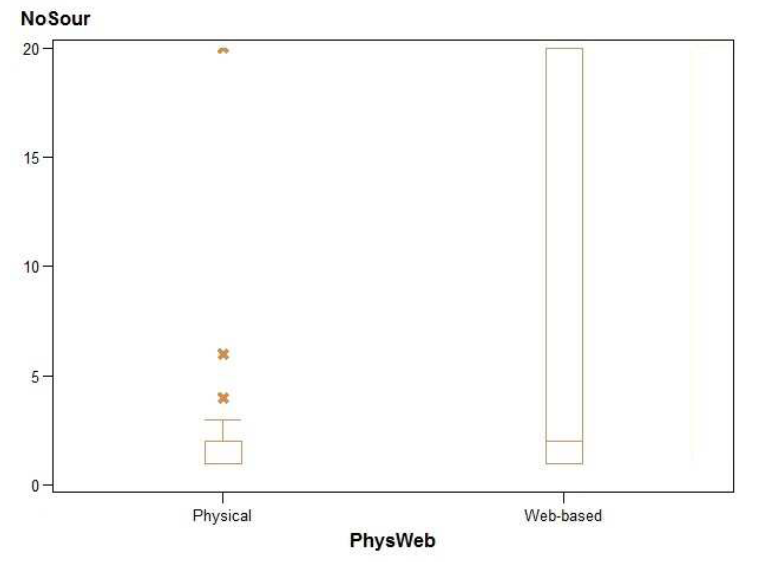
Figure 2 – Box-plot of number of funding sources in Physical and Web-based